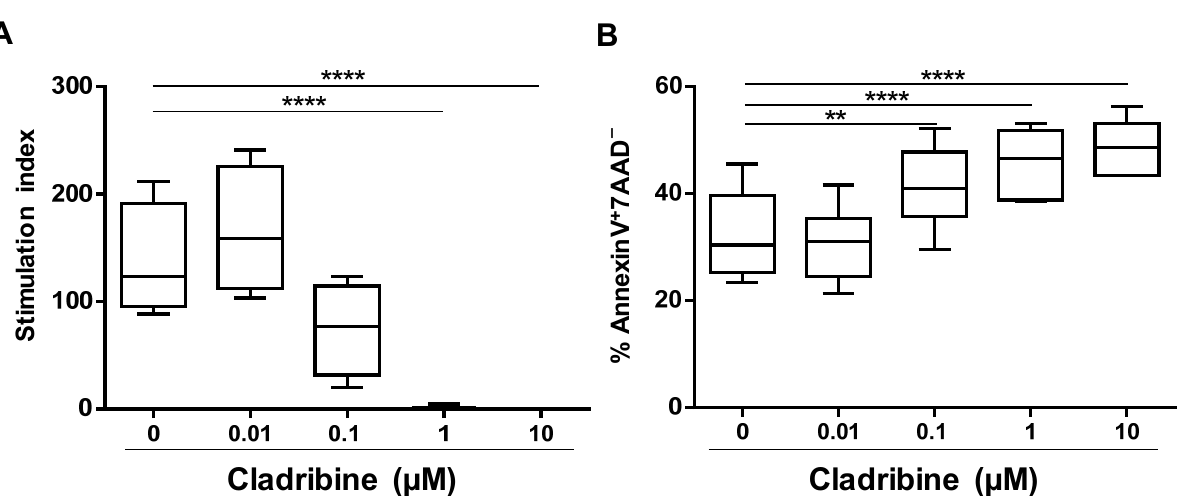
Figure 1. Dose–response effect of cladribine on cell proliferation and apoptosis of PBMCs. ( A ) Proliferation was deter- mined by the incorporation of [ 3 H]-thymidine. PBMCs were stimulated with PHA for 42 h in the presence of increasing concentrations of cladribine (0.01 µ M, 0.1 µ M, 1 µ M and 10 µ M). Stimulation indices were calculated as the ratios of the mean counts per minute of PBMCs, in the different conditions of culture, with respect to unstimulated and untreated PBMCs. ( B ) Cellular viability was assessed by flow cytometry, by means of Annexin V/7AAD staining on PHA-stimulated PBMCs treated with cladribine at 0.01 μ M, 0.1 μ M, 1 μ M, 10 μ M, or left untreated for 16 h. Apoptotic cells were defined as Annexin V + 7AAD − cells. One-way ANOVA with repeated measures followed by a multiple comparison Dunnett’s test was performed, comparing every mean value with a control of the untreated group mean (0 group). ** p -value ˂ 0.01, **** p -value ˂ 0.0001. ( N = 6).